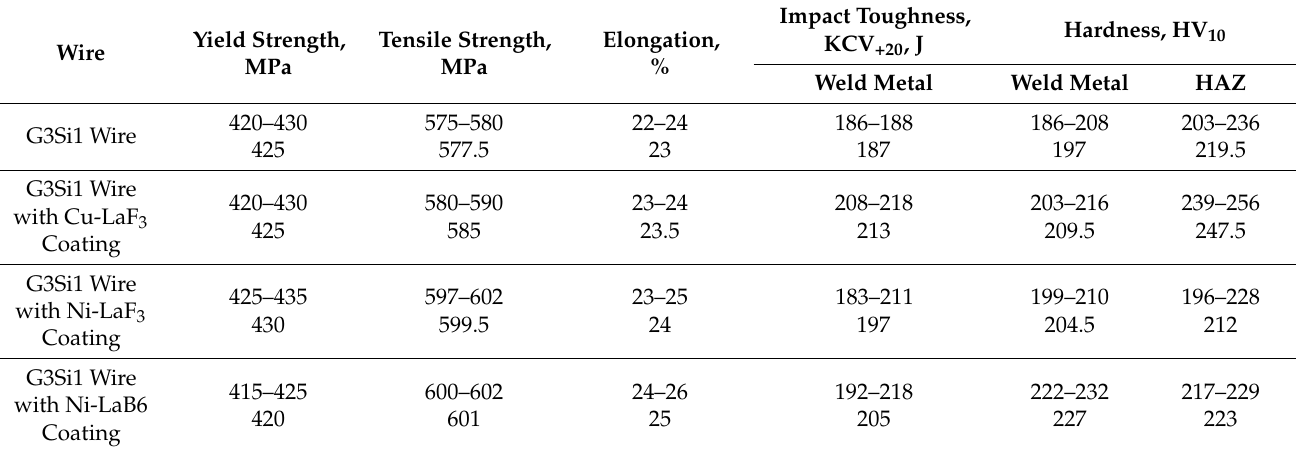
Table 5. The mechanical properties of the welds of 10HSND steel with G3Si1 wire.